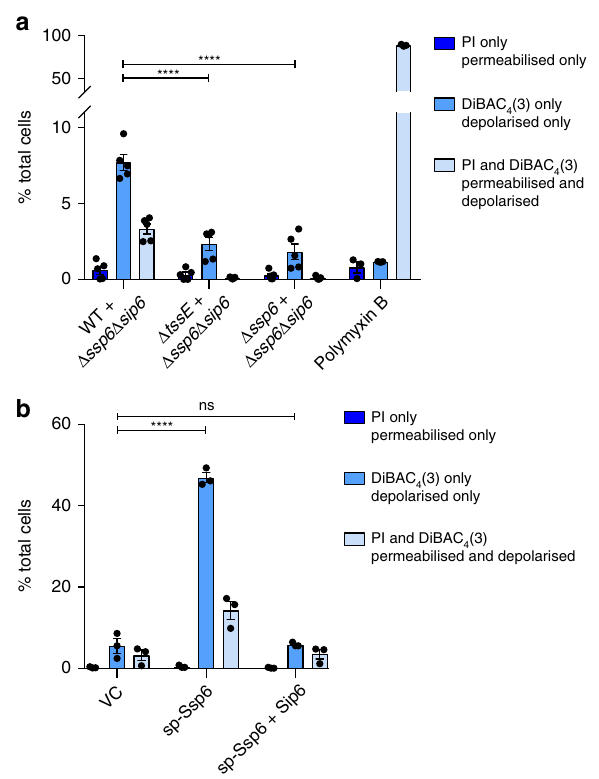
Fig. 3 Ssp6 intoxication via T6SS delivery or heterologous expression causes loss of membrane potential. a The Ssp6-susceptible mutant of S. marcescens Db10, Δ ssp6 Δ sip6 , was co-cultured with the wild type (WT), Δ tssE mutant or Δ ssp6 mutant and then membrane potential and membrane permeability of the mixed population was determined. Cells were stained with DiBAC 4 (3) and propidium iodide (PI) and analysed by fl ow cytometry, allowing different populations to be detected: depolarised (increased green fl uorescence from DiBAC 4 (3)), permeabilised (red fl uorescence from PI), depolarised and permeabilised cells (green fl uorescence and red fl uorescence), and healthy cells (below threshold fl uorescence). The percentage of cells in the total mixed co-culture population identi fi ed as being permeabilised only, depolarised only, or simultaneously depolarised and permeabilised is shown on the Y -axis. Bars show mean + / − SEM, with individual data points superimposed ( n = 5 independent experiments, except for the polymyxin B control, where n = 3; **** p < 0.0001, one-way ANOVA with Dunnett ’ s test). b Membrane potential and permeability of cells of E. coli MG1655 carrying empty vector control (VC, pBAD18-Kn) or plasmids directing the expression of Ssp6 fused with an N-terminal OmpA signal peptide (sp-Ssp6), either alone or with Sip6, was determined as in part a. Bars show mean + / − SEM, with individual data points superimposed ( n = 3 independent experiments; **** p < 0.0001, one-way ANOVA with Dunnett ’ s test). Source data are provided as a Source Data fi